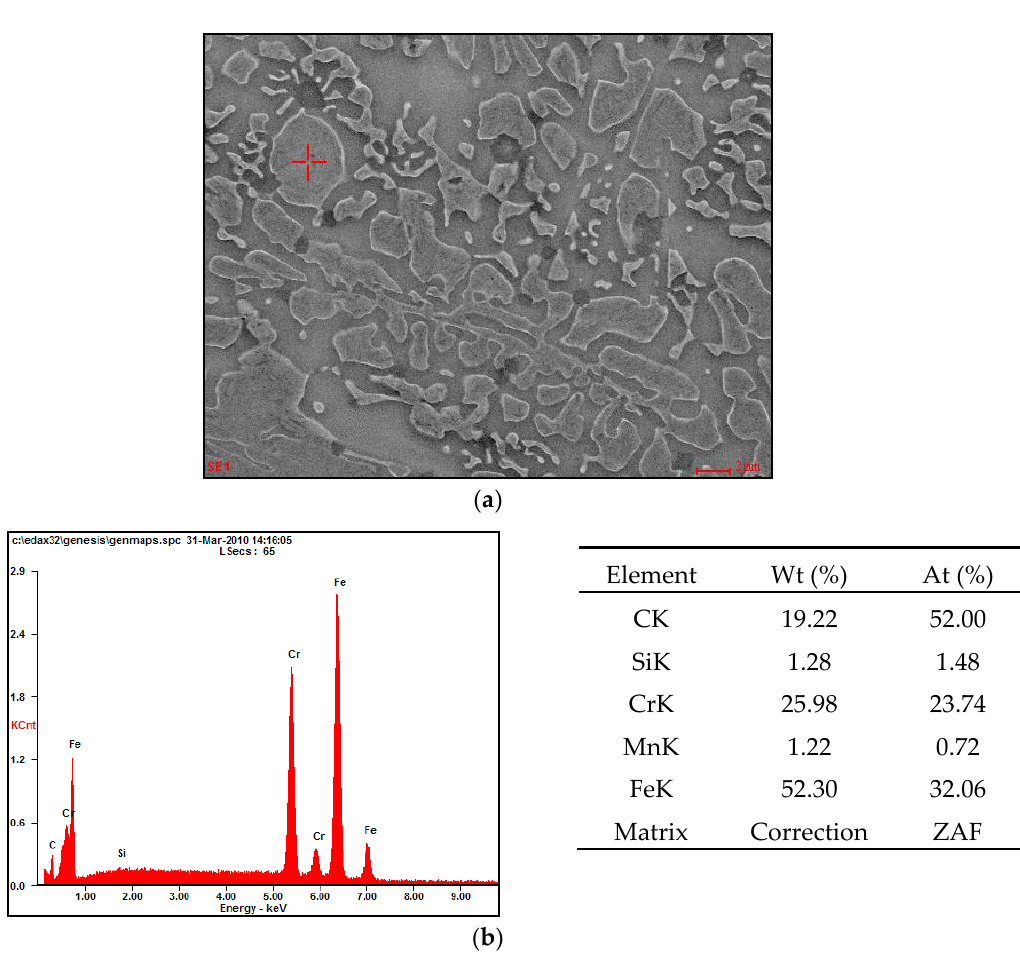
Figure 11. ( a ) SEM image of the nanostructural layer microstructure over the EDS analysis area—a precipitation of chromium carbide; ( b ) the EDS spectrum showing the above indicated spot-separation of chromium carbide and results of the quantitative elemental analysis.